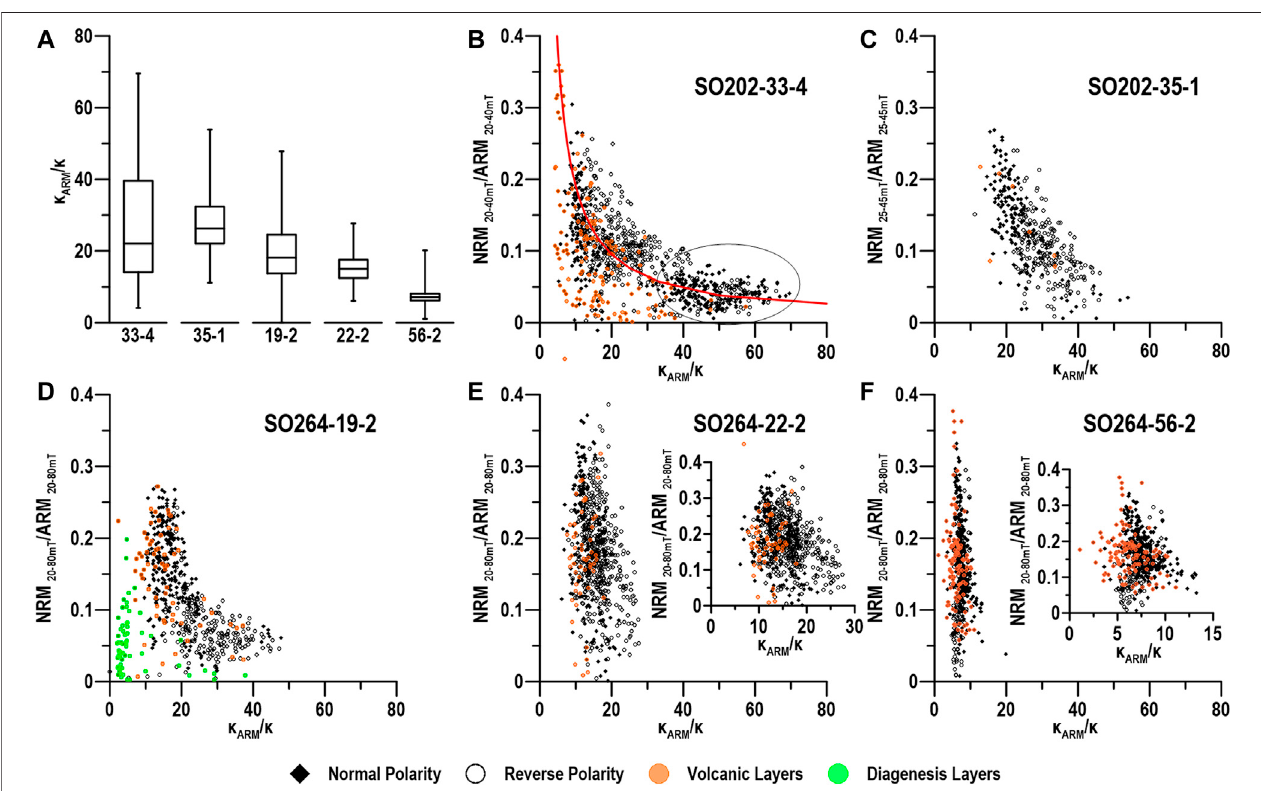
FIGURE10 |(A) Box-and-whisker plotsof κ ARM / κ records (B – F) RPI vs. κ ARM / κ biplots for cores (B) SO202-33-4, (C) SO202-35-1, (D) SO264-19-2, (E) SO264- 22-2, and (F) SO264-56-2. Solid (open) symbols depict intervals of normal (reverse) magnetic polarity. Orange and green symbols represent data points from volcaniclastic and diagenesis layers, respectively. Small plots with extended x -axes have been inserted in (E) and (F) .